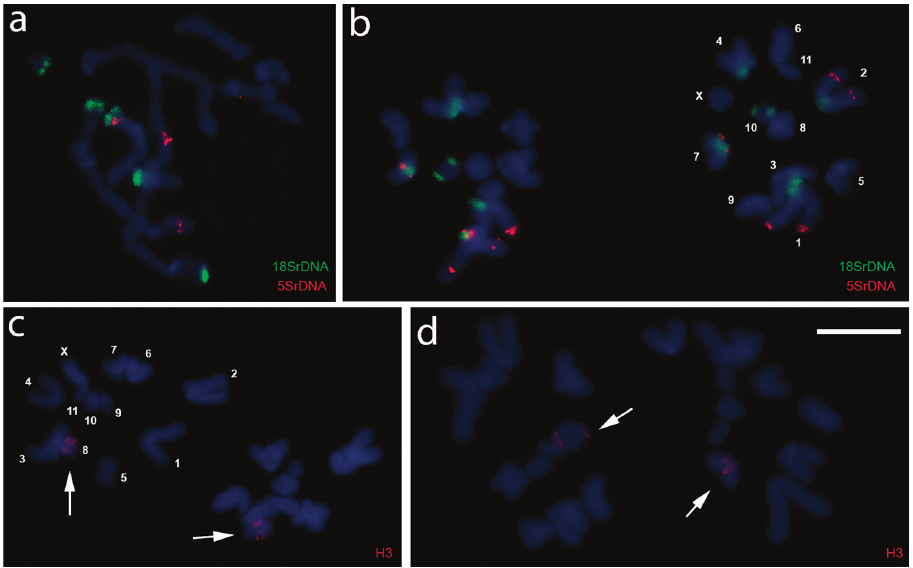
Figure 2. Fluorescent in situ hybridization of A. flavolineata in meiocytes: a, b 18S rDNA (green) and 5S rDNA (red) probes c, d histone H3 gene probe: a pachytene b–d two cells in metaphase II. The numbers correspond to autosomes. X corresponds to the sex chromosome. The arrows indicate the histone H3 gene sites. Bar=